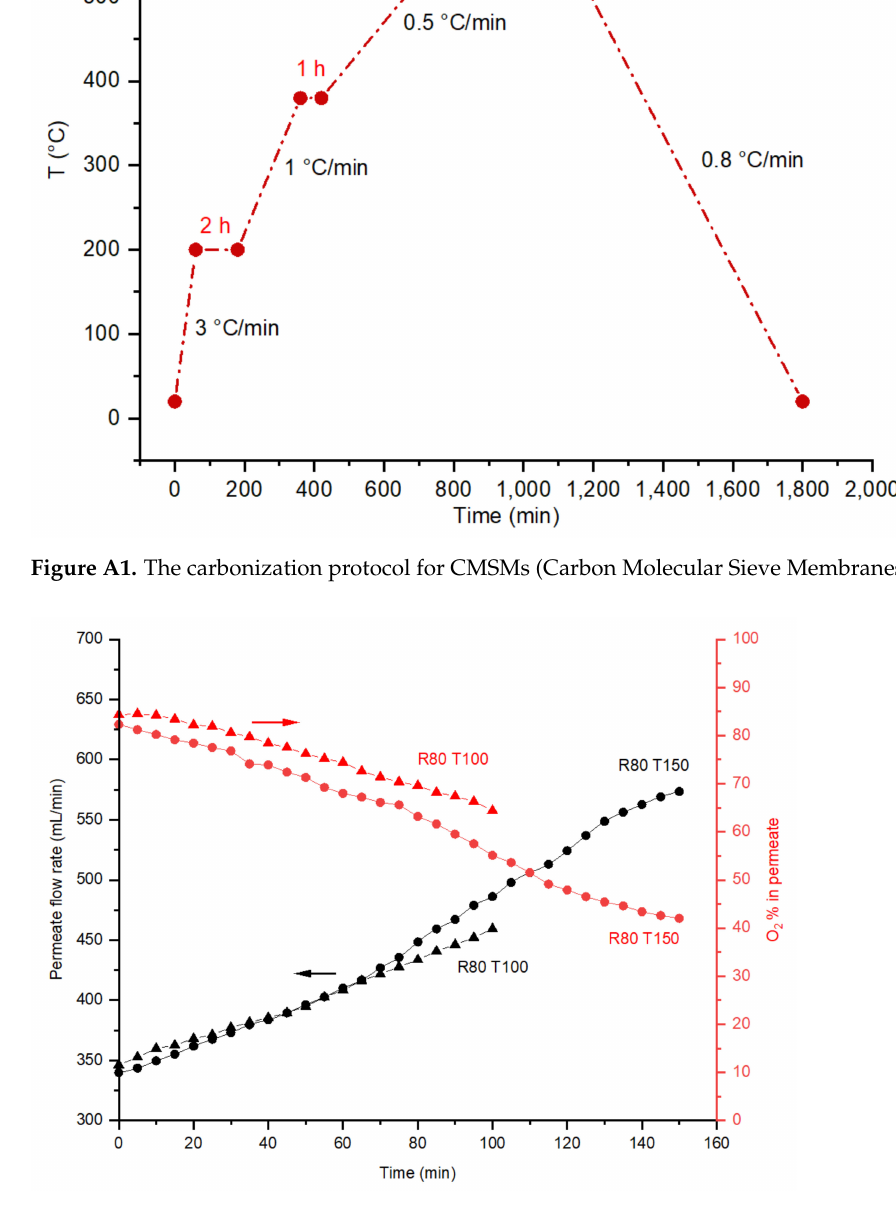
Figure A2. The effect of post treatment of CMSMs (Carbon Molecular Sieve Membranes) in the perme- ate flow rate (SD 4%) and oxygen concentration in permeate, measured by GC (Gas Chromatograph) that are treated at 120 ◦ C and 6 bar with 10% oxygen in the feed